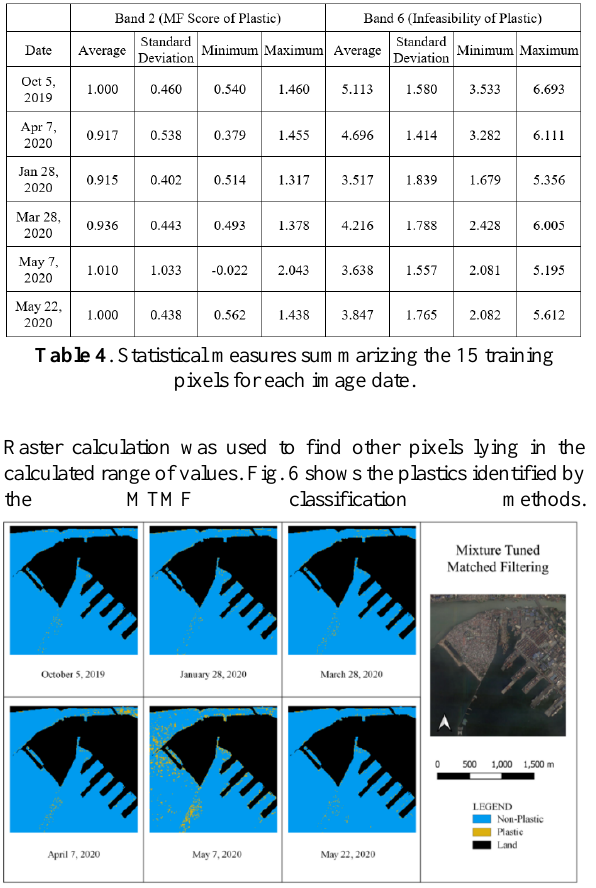
Figure 6 . Mixture Tuned Matched Filtering result for